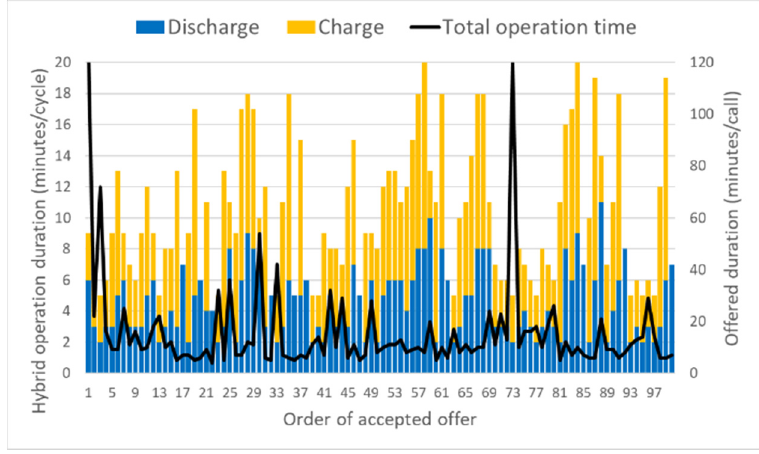
Figure 11. Charge and discharge duration of first 100 calls.